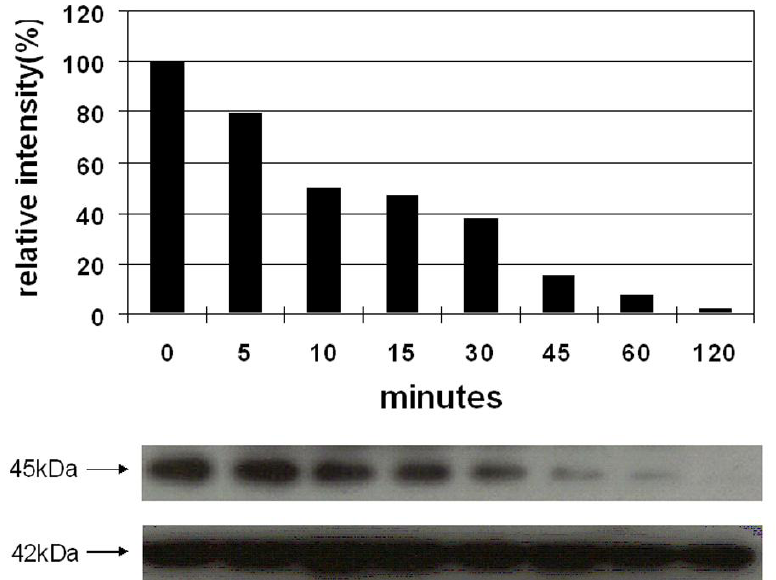
Figure 3. Vessel dilator at 10 μM inhibits 98% of the phosphorylation of mitogen-activated protein kinase kinase (MEK 1/2), which was maximal at two hours and significant at p < 0.00001 when evaluated by analysis of variance (ANOVA). MEK 1/2 is at 45 kDa while B-actin (loading control) is 42 kDa. The relative intensity in the bar graphs is a comparison against untreated MEK 1/2 (100% intensity). Reprinted with permission from